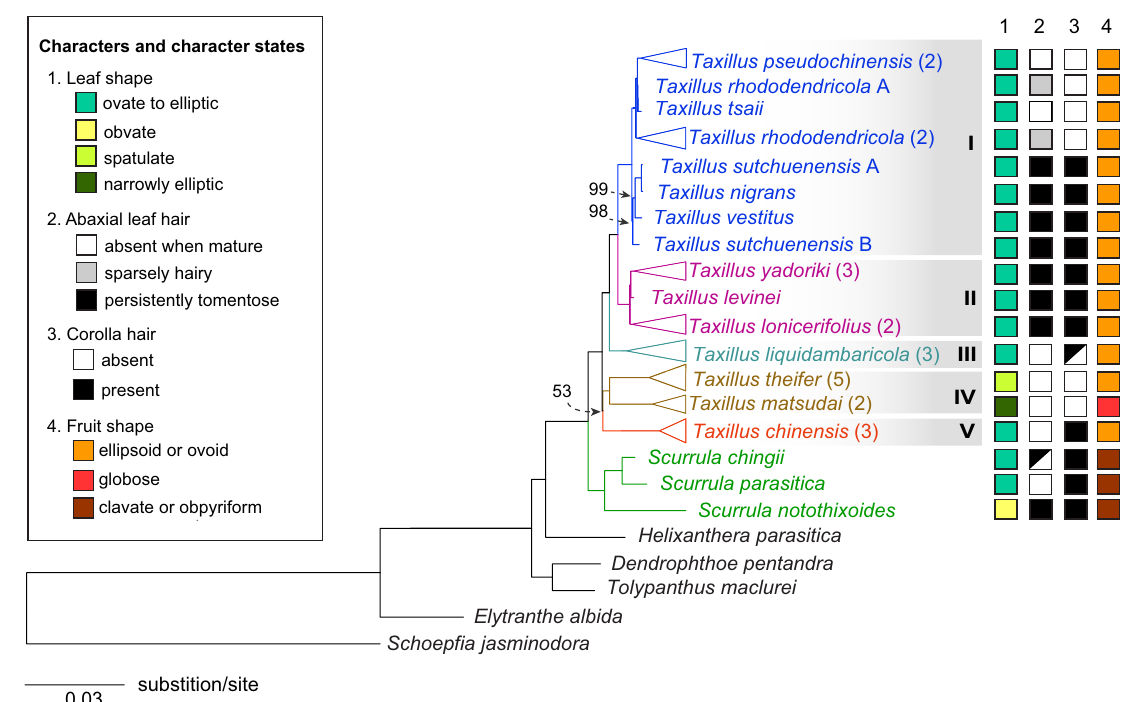
Fig 1. Phylogenetic tree of Taxillus and other Loranthaceae. This ML tree derives from analysis of the 67 gene sequence dataset (63 PCGs and four rRNAs). Only bootstrap values < 100% are labeled and Schoepfia jasminodora was used as the outgroup. Triangles at the branch tips represent multiple accessions of the same species and the number of accessions used is shown in parentheses. Four morphological characters and their states are shown to the right of the phylogenetic tree. The grey shading marks the five major clades of Taxillus (see